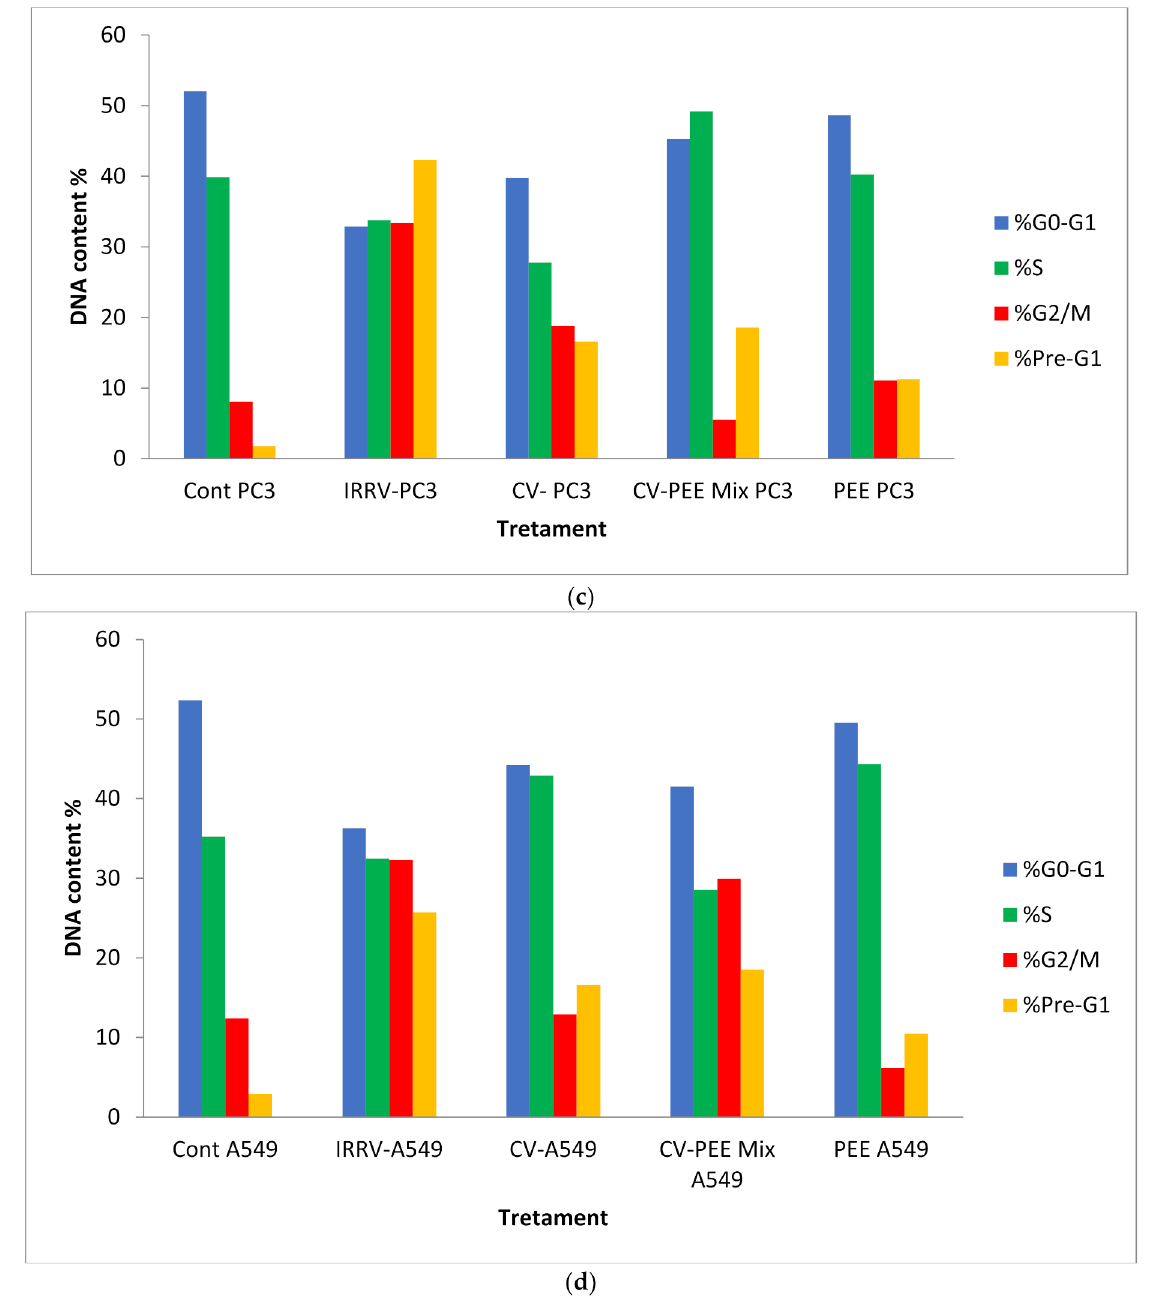
Figure 3. ( a ) Evaluation of apoptosis of PC3 cell lines with IRRV, CV, and CV-PEE Mix compared with cell cycle profile of untreated cell control. ( b ) Evaluation of apoptosis of A549 cell lines with IRRV, CV, and CV-PEE Mix compared with cell cycle profile of untreated cell control. ( c ) Evaluation of DNA content of PC3 cell lines with IRRV, CV, and CV-PEE Mix compared with cell cycle profile of untreated cell control. ( d ) Evaluation of DNA content of A549 cell lines with IRRV, CV, and CV-PEE Mix compared with cell cycle profile of untreated cell